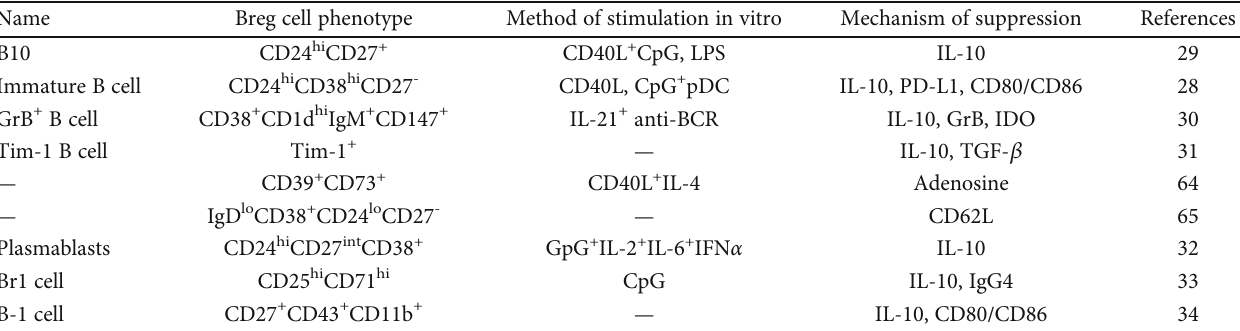
Figure 1: The source of Breg. Di ff erent from Treg, Breg has more extensive sources. It does not matter whether they are B1 cells or B2 cells, or if they are immature B cells or mature B cells, under certain conditions of stimulation, Breg with immunomodulation function can be di ff erentiated. At present, the main mechanism by which Breg plays the immune regulatory function in the human body is the secretion of Table 1: Breg found in human peripheral blood.